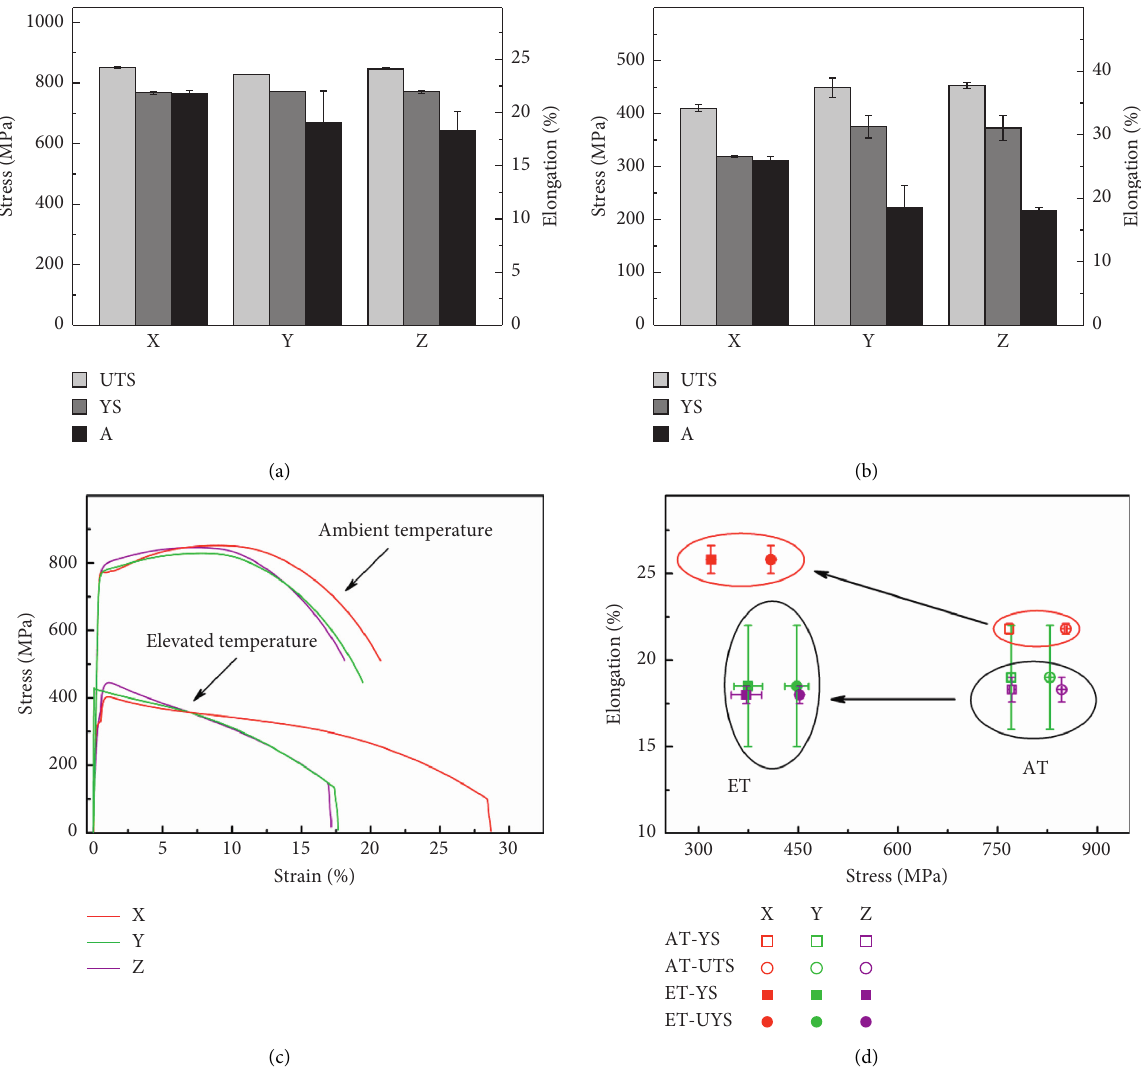
Figure 5: Tensile properties of the deposit. (a) Ambient and (b) elevated temperature tensile properties; (c) stress-strain curves; (d) comparison of ambient and elevated temperature tensile